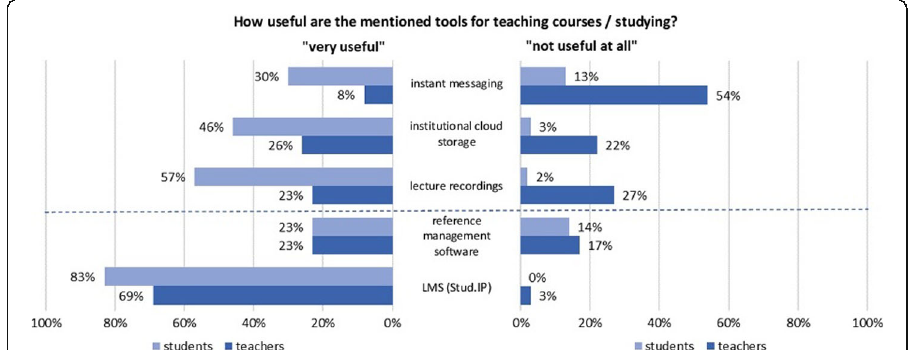
Fig. 3 Student and teacher perceived usefulness of